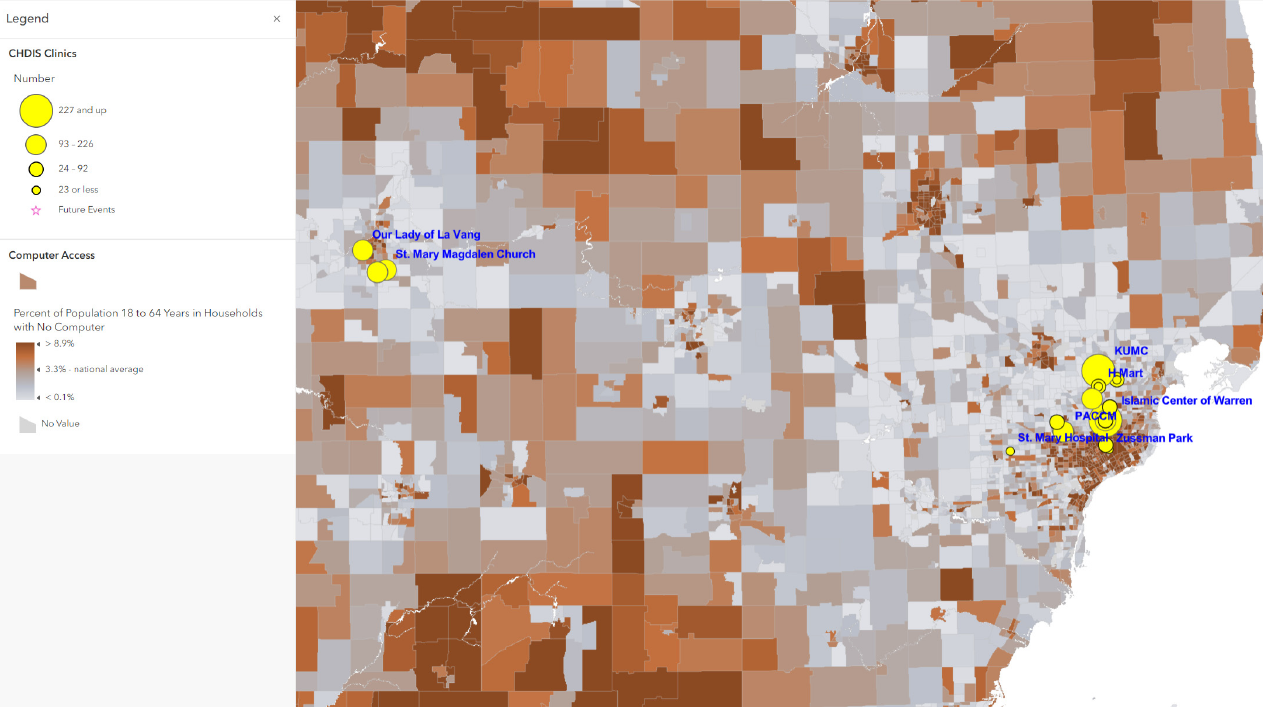
Figure 4. EMU mobile clinics vs. percent of population with no health insurance coverage.